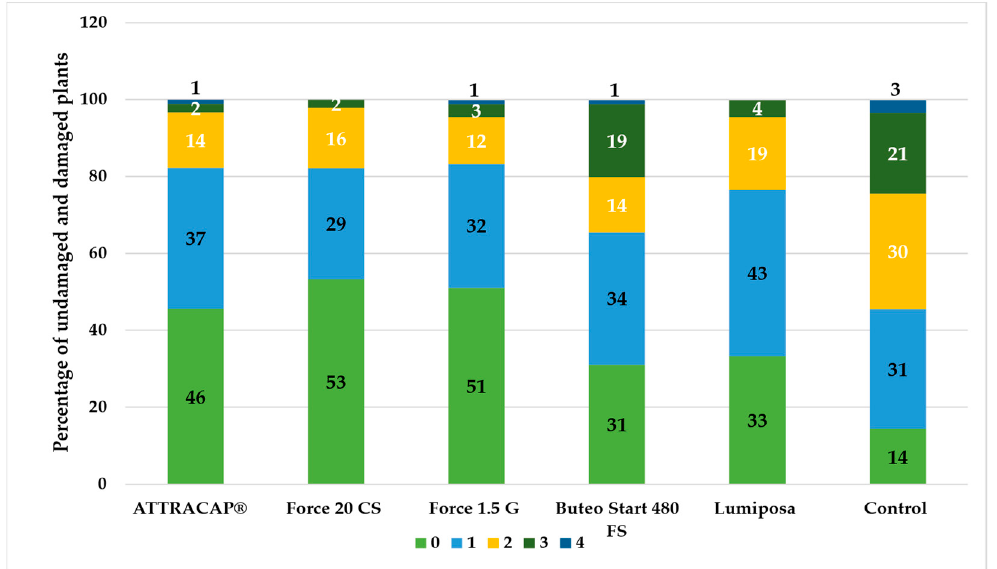
Figure 8. Percentage of plant damage levels 0–4 in different insecticidal treatments in the sunflower field RŠ T-12 in the year 2021.